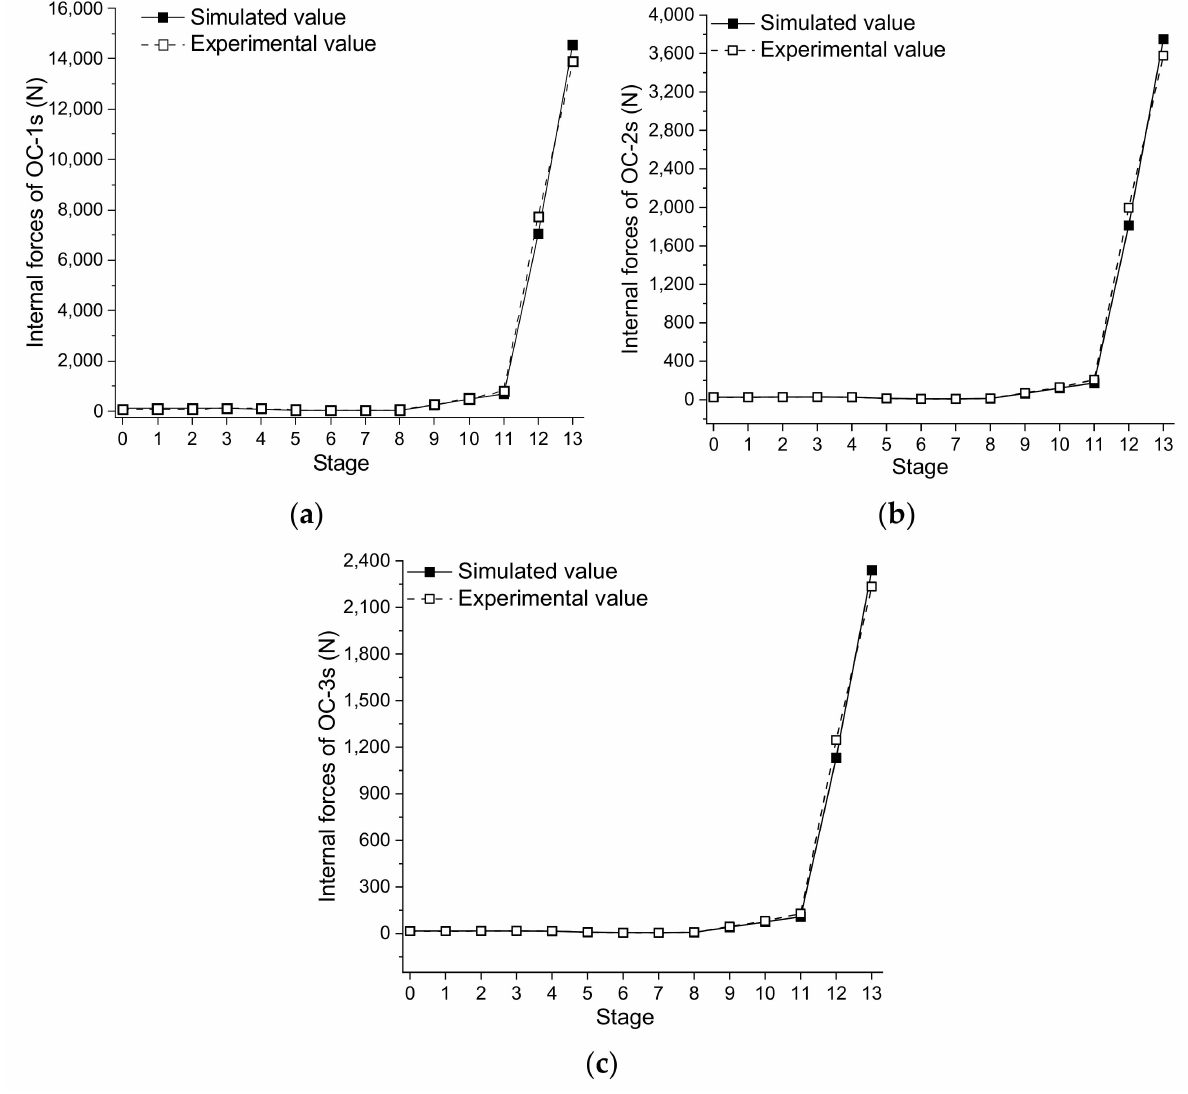
Figure 20. Internal forces of OC-s during construction. ( a ) OC-1; ( b ) OC-2; ( c )